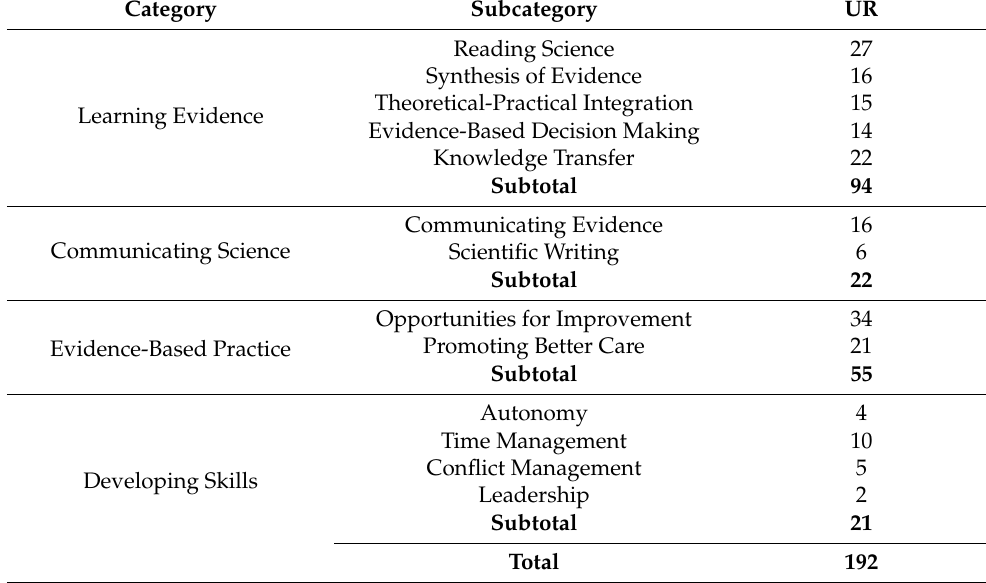
Table 2. Corpus of content